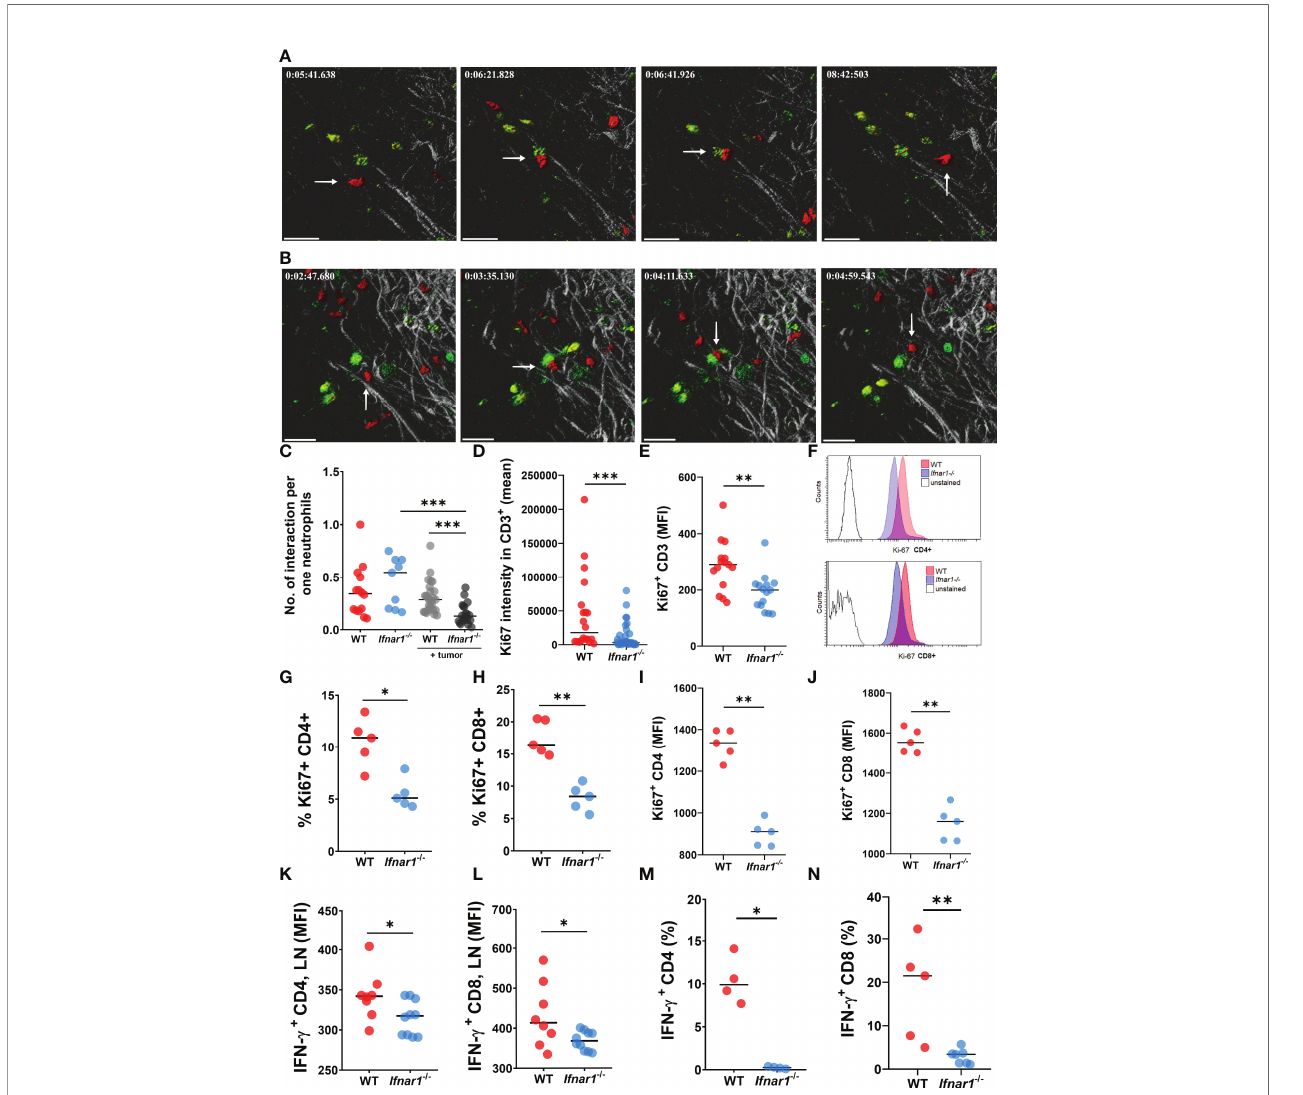
FIGURE 4 | Impaired interactions between neutrophils and T-cells in TDLNs. (A, B) Tumor decreases the number of interactions between neutrophils and T-cells in LNs of tumor-bearing WT (A) and Ifnar1 -/- (B) mice. Exempli fi ed pictures showing TDLN neutrophils in red (tdTomato), T-cells in green (FITC), and LNs tissue in grey (auto fl uorescence). Corresponding movies available in supplements. Scale bar 30 µm. The white arrows indicate the neutrophil that interacts with T-cell. (C) Growing primary tumor impairs interactions between neutrophils and T-cells in TDLNs of tumor-bearing animals, especially in Ifnar1 -/- mice, in comparison to tumor-free animals (interactions were estimated during 15 minutes and normalized per one neutrophil, in an in vivo system) . (D – J) Signi fi cantly reduced T-cell activation in TDLNs in Ifnar1 -/- mice, estimated by Ki-67 expression on TDLN cryo-sections (D) and fl ow cytometry for all T Lymphocytes (E) and for both CD8 and CD4 subpopulations (G – J) . (F) Representative histograms showing down-regulated expression of Ki-67 in CD4 and CD8 cells of tumor-bearing Ifnar1 -/- mice in comparison to WT mice. (K, L) Impaired IFN- ɣ expression in CD4 (K) and CD8 (L) cells in TDLNs of Ifnar1 -/- . (M, N) Suppressed T-cell activation after co-incubation with Ifnar1 -/- TDLN neutrophils visualized by IFN- g production in both CD4 (M) and CD8 (N) cell populations, in an in vitro setting. For (A – C) tumor cells were injected s.c. into the fl ank of mice. Two-photon microscopy of the previously surgically exposed inguinal TDLNs was performed on day 14. Cell interactions were manually counted in ROIs over the duration of 15 minutes. Representative results from six replicate experiments are shown for (A, B) , n=5 for WT animals, n=8 for WT tumor- bearing animals, n=5 for Ifnar1 -/- animals, n=8 for Ifnar1 -/- tumor-bearing animals. For (D – J, K, L) tumor cells were injected s.c. into the fl ank of mice. Mice were sacri fi ced on day 14 post tumor induction, LNs were collected, immuno fl uorescent histological staining (quanti fi cation of CD3 + and CD3 + Ki67 + cells, 10 fi elds of view 1mm 2 ) (D) and fl ow cytometry (Ki67 expression on single alive CD3 + , CD3 + CD4 + and CD3 + CD8 + cells) (E – G) were performed. Representative results are shown for thee experiment for (D) , n=10 for each cohort and for three experiments for (E) , n=5 for each cohort and three replicate experiments. Representative results are shown for two replicate experiments for (G – J) , n=5 for each cohort. For (M, N) tumor cells were injected s.c. into the fl ank of mice. Mice were sacri fi ced on day 14 post tumor induction, LNs were collected and neutrophils (single alive Ly6G + CD11b + cells) were isolated using fl ow sorting. T-cells (single alive CD3 + cells) were isolated from the spleens of naïve WT mice using fl ow sorting and co-incubated with neutrophils. On day 3 the intracellular expression of IFN- ɣ in single alive CD4 + and CD8 + cells was estimated by fl ow cytometry. Representative results are shown for two experiment for (M) , n=4 for each cohort and two replicate experiments for (N) , n=5 for WT, n=7 for Ifnar1 -/- . For comparison of two independent groups, Mann-Whitney U test was used. Data are shown as an individual values with median. *p < 0.05, **p < 0.01, ***p <